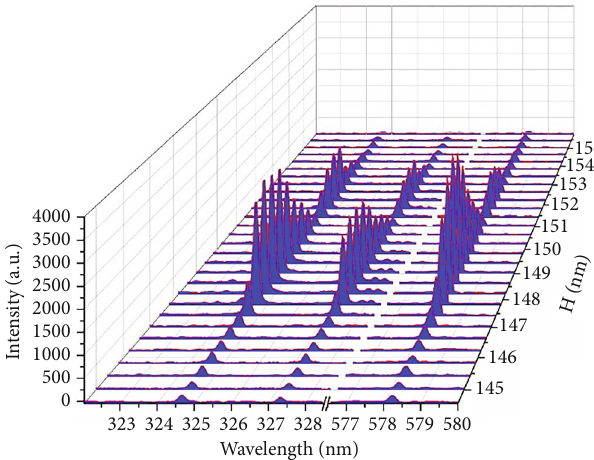
Figure 3: Graph showing the spectra of the three Cu(I) lines with H ( f = 150 mm, pulse energy is